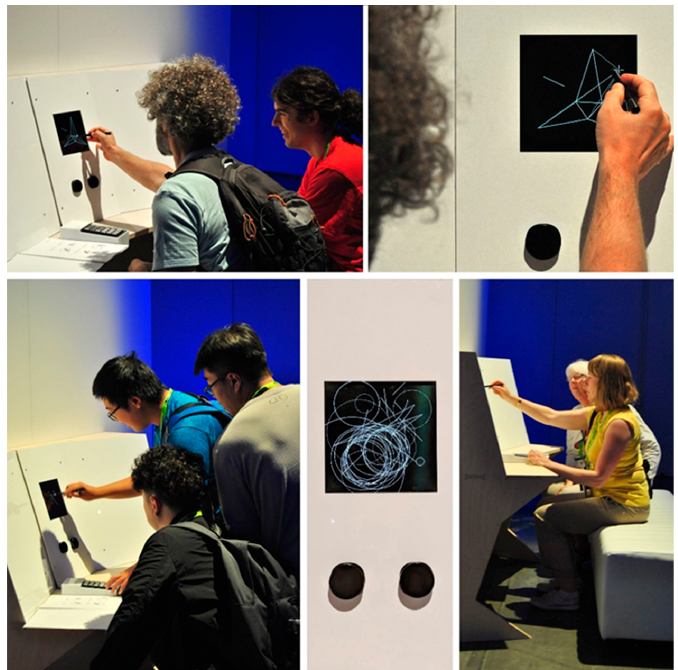
Figure 7. “ Sketchpad ” reconstruction by Daniel Cardoso-Llach. Used by permission of Daniel Cardoso-Llach. Photographs by Daniel Cardoso-Llach.